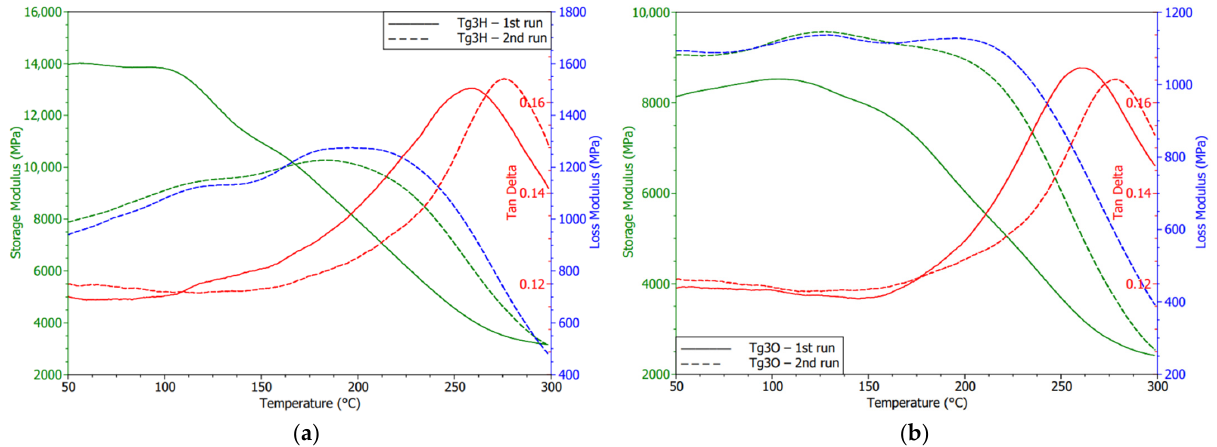
Figure 16. DMA diagrams of the Tg3 substrate with the following surface finish: ( a ) HASL; ( b )